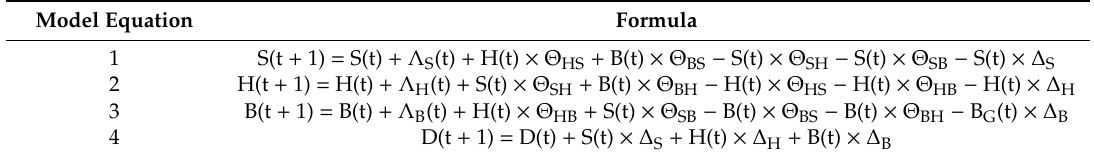
Figure 1. Framework of the model used in this study. Table 1. Summary of the liner di ff erence equations used to estimate volume of patients in social, home, bedridden, and dead